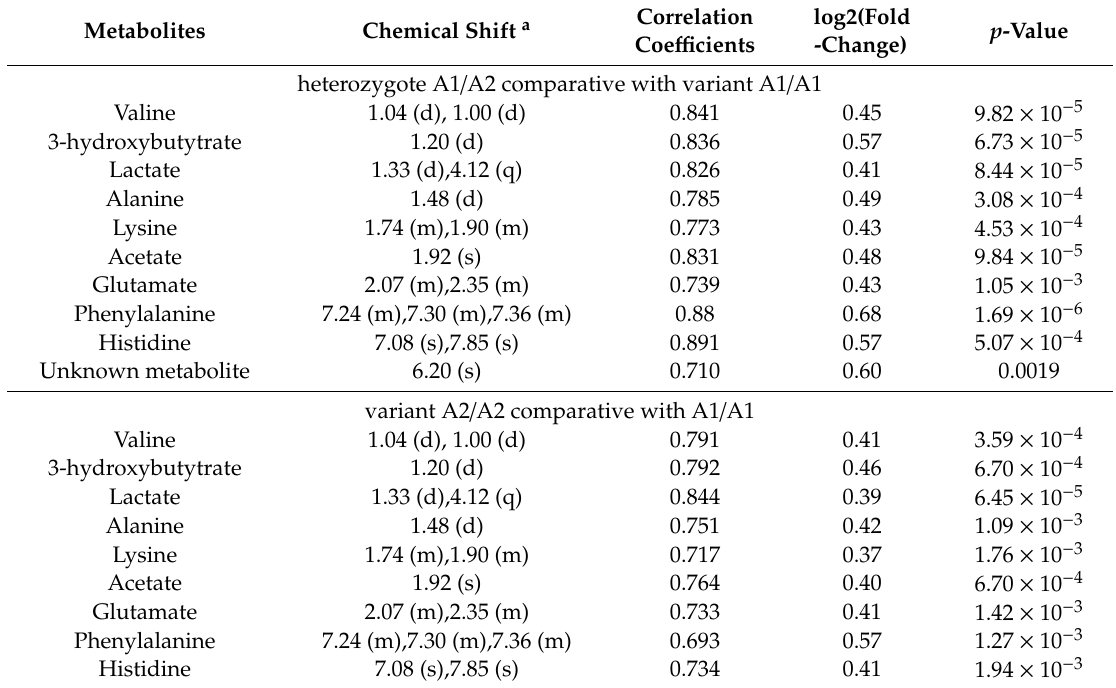
Table 1. Di ff erential metabolites from β -casein variants A1 / A1 (A1) and A2 / A2 (A2) or heterozygote A1 / A2 (A12)